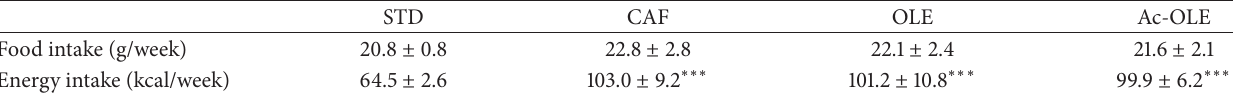
Table 3: Effects of Ole and Ac-Ole on food and energy